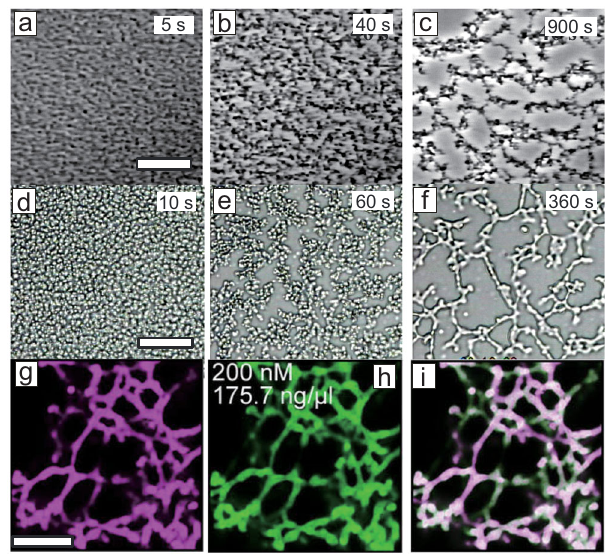
Fig. 3 Pattern evolution in viscoelastic phase separation (VPS). a – c A phase separation process observed in a mixture of polystyrene ( M w ¼ 7 : 04 ´ 10 5 ) and diethyl malonate (0.5 wt% polystyrene) at 20 °C with phase-contrast microscopy. The scale bar corresponds to 50 μ m. d – f A phase separation process observed in a protein solution (protein concentration c ¼ 200 mg ml − 1 , salt concentration 7.5 wt%) at 37 °C with conventional optical microscopy. The scale bar corresponds to 50 μ m. g – i Dynamic mesh-like condensates of TIS ((TPA (12-0-tetradecanoyl- phorbol-13-acetate)-inducible sequence protein)) granules formed in vitro 14 . Confocal images of phase separation experiments using puri fi ed mGFP (membrane-bound form of green fl uorescent protein)-FUS (Fused in Sarcoma)-TIS (10 mM) in the presence of the indicated in vitro transcribed RNAs (ribonucleic acid) (CD274 3 ′ UTRs (untranslated regions) (2075 nt); 200 nM, 175.7 ng μ l − 1 ) after 16 h of incubation. g Image of FUS-TIS signal; h Image of RNA signal; i Merge of FUS-TIS and RNA signals. Five per cent dextran was added into the phase separation buffer as a crowding agent. The scale bar corresponds to 10 μ m. These images in g – i are reproduced from the fourth column of Fig. 2a of ref. 14 .